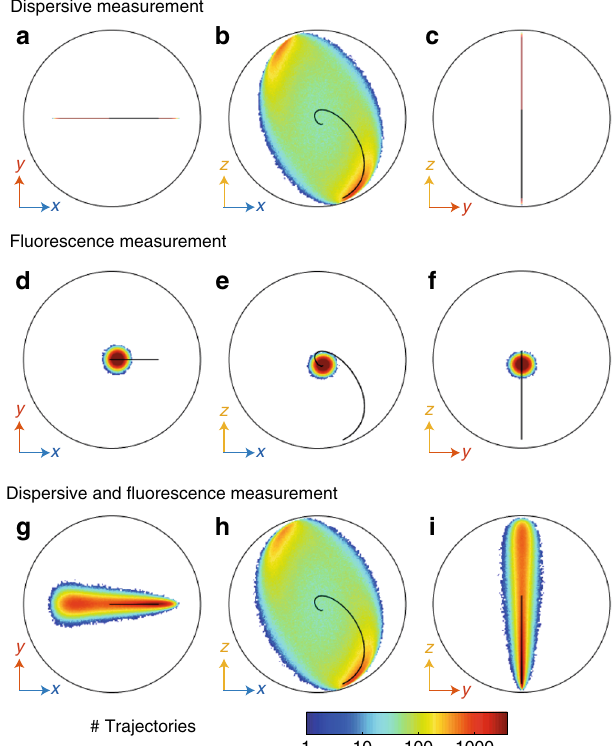
Fig. 5 Impact of the type of detector on the distribution of quantum states. a – c Marginal distribution in the x − y ( a) , x − z ( b) , and y − z ( c) planes of the Bloch sphere of the qubit states ρ τ corresponding to 1.5 millions of measurement records at the cavity frequency only { w ( t )} for time t between 0 and τ = 6.5 μ s. The information about { u ( t ), v ( t )} is here discarded ( η f = 0). All panels in the fi gure correspond to the Zeno regime ( Ω /2 π = (5.2 μ s) − 1 ≪ Γ d = (0.9 μ s) − 1 ) As in Fig. 4, the boundary of the Bloch sphere is represented as a black circle and the average quantum trajectory as a solid line. d – f Case where the states are conditioned on fl uorescence records { u ( t ), v ( t )} instead while discarding the information on { w ( t )} ( η d = 0). g – i Case where the states are conditioned on both fl uorescence and dispersive measurement records { u ( t ), v ( t ), w ( t